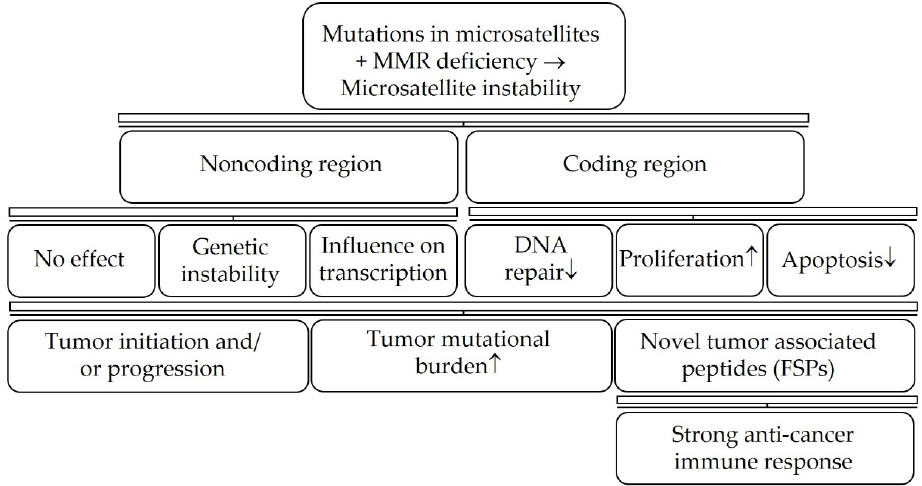
Figure 6. Summarized are the sequelae of mismatch repair (MMR) deficiency and microsatellite instability. FSPs = frameshift-associated peptides.